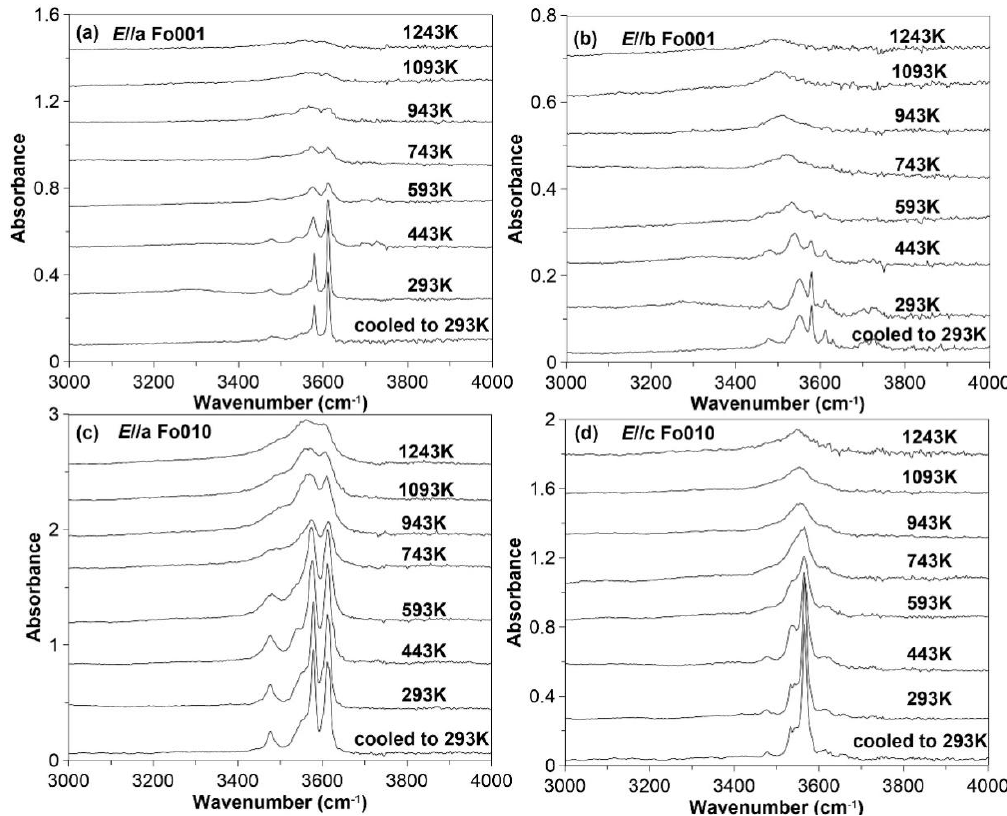
Figure 6. Polarized IR spectra for the oriented Fo001 ( a for E//a and b for E//b ) and Fo010 ( c for E//a and d for E//c ) directions, at high temperatures.